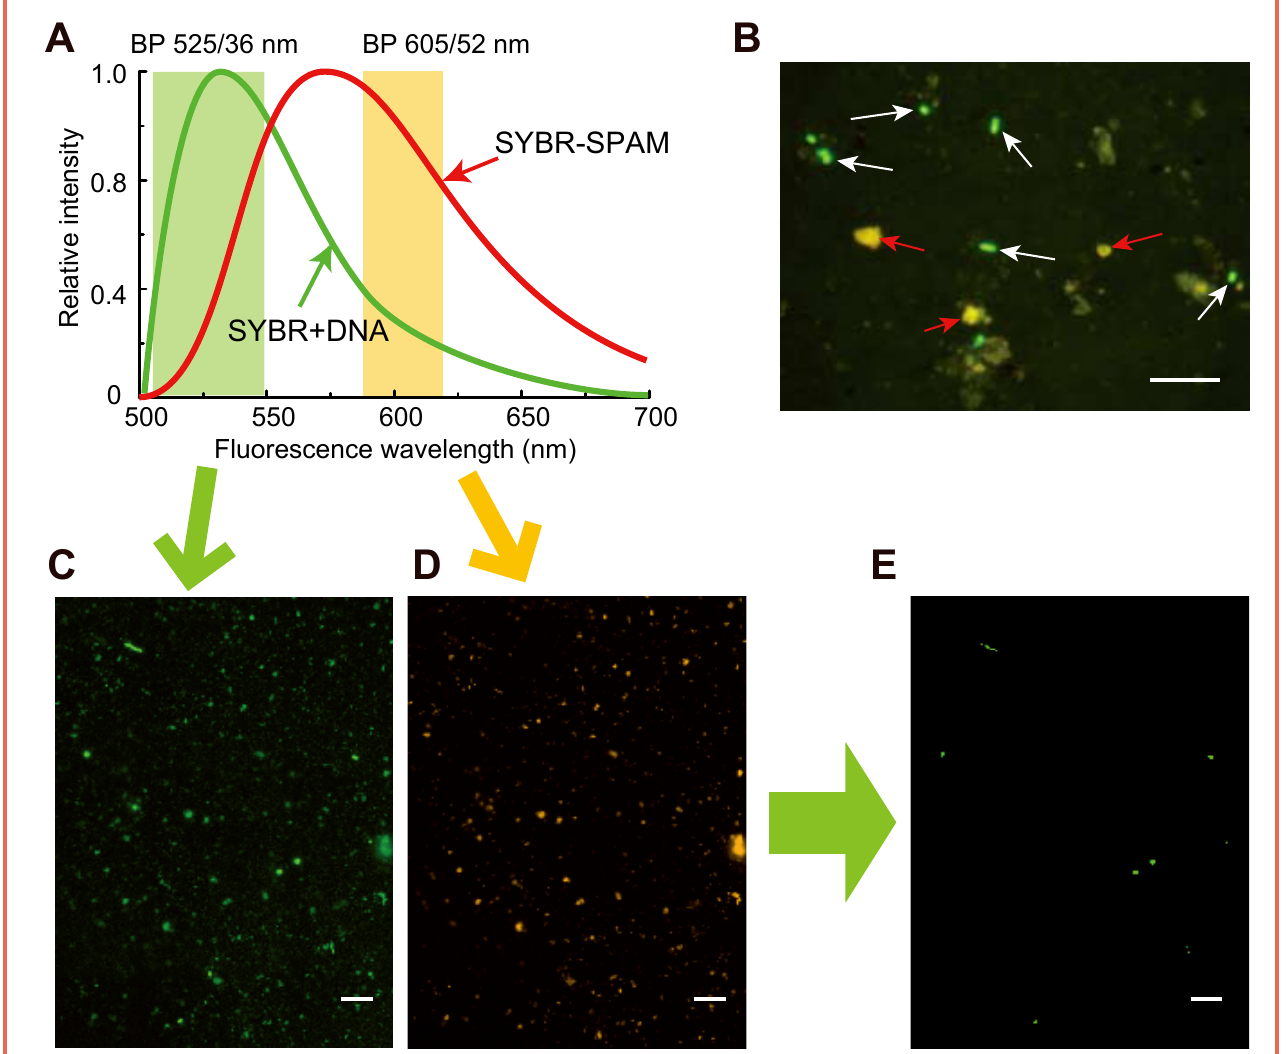
Figure 1. Difference of SYBR-I fluorescence spectrum with intracellular DNA or SYBR-SPAM, and discrimination of cell-derived SYBR Green I fluorescence from background signals using image analysis. [A] Spectrum patterns show “red shift” of SYBR-I fluorescence. When SYBR-I binds to SYBR-SPAM (red line), fluorescence spectra shift to longer wavelengths than SYBR-DNA complex (green line). Green and orange shaded areas show the wavelength range of 525/36 and 605/52 (nm of center wavelength/bandwidth) band-pass filters, respectively. [B] Examples of fluorescence-producing cellular and non-cellular objects stained with SYBR-I. Red arrows, yellowish SYBR-SPAM. White arrows, green E. coli cells. The image was obtained using a long-pass filter of cut-off wavelength 510 nm. [C to E] Image analysis to distinguish cell-derived SYBR-I signals from SYBR-SPAM in natural marine sediments (core 1H-1 of Site C0006 Hole E in the Integrated Ocean Drilling Program Exp. 316). Fluorescence microscopic images taken using band-pass filters of 525/36 [C] and 605/52 [D]. Relative intensity profiles of green/red fluorescence [E] show only cell-derived fluorescence signals without background fluorescence. Bars: 10